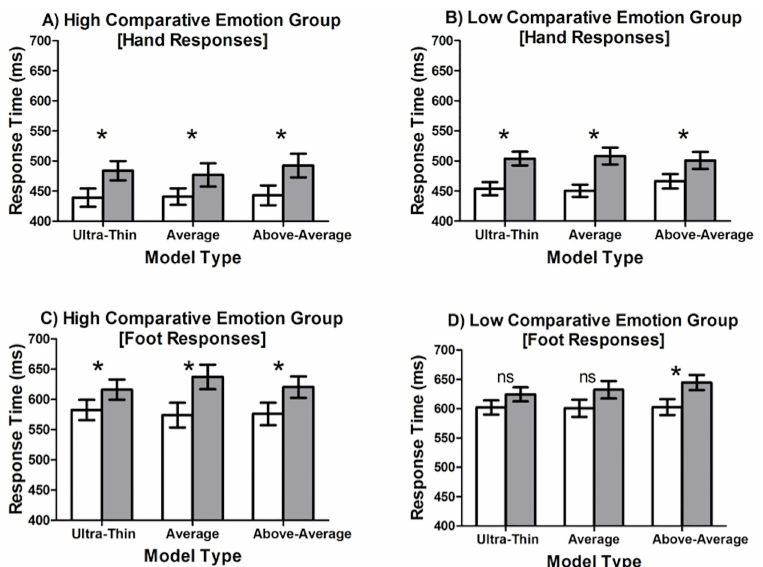
Fig 1. Mean RT (ms) for hand and foot responses in high comparative (A & C) and low comparative (B & D) emotion groups. White bars represent compatibleresponses and gray bars represent incompatible responses. Standard errors of the compatibleand incompatible means are